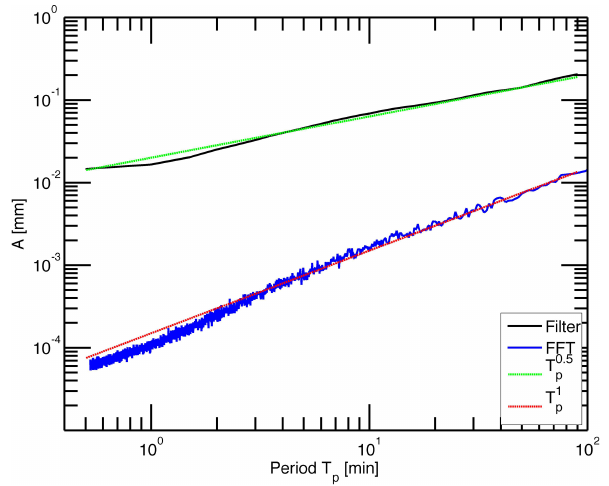
Figure 3. Amplitude spectra of IWV fluctuations observed at Bern for the four seasons of the year 2010. The green, red, blue, and black lines are obtained by a band pass filtering method for winter, spring, autumn, and summer respectively. The magenta line shows the inclination for A ∼ T 0 . 5 p (or power P ∼ f − 1 ) where f is the frequency and T p is the